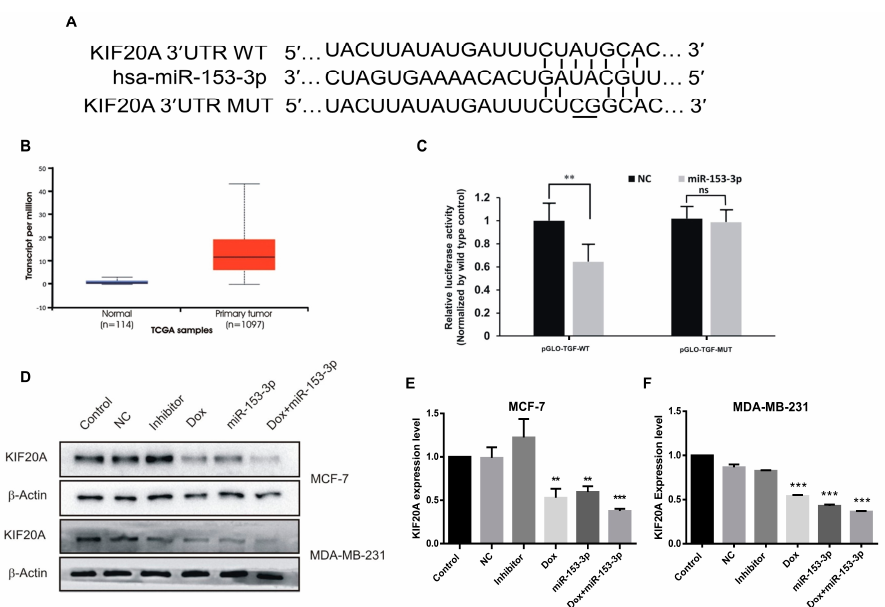
Figure 3. KIF20A is a direct target gene of miR-153-3p and was downregulated by miR-153-3p. ( A ) Binding sites of miR-153-3p in the 3’-UTR of KIF20A. ( B ) KIF20A expression analysis in the TCGA database. ( C ) Quantification of relative luciferase activity in wild-type and mutant vectors. Data is the mean ± SD of three separate experiments. ( D ) Expression levels of KIF20A were detected by Western blotting (original blot see Supplementary File S1). ( E , F ) Quantitative analysis of KIF20A expression levels in MCF-7 cells and MDA-MB-231 respectively (ns: not significant; ** p < 0.01; *** p < 0.001. Cancers 2023 , 15 , x FOR PEER REVIEW To investigate the effects of miR-153-3p, doxorubicin, and the combination on apop- tosis, flow cytometry analysis was performed on both cancer cell lines. In MCF-7 cells the percentage of early and late apoptotic cells was 12.43% in doxorubicin-treated cells, while when combined with miR-153-3p treatment, the number of apoptotic cells reached 33.9%